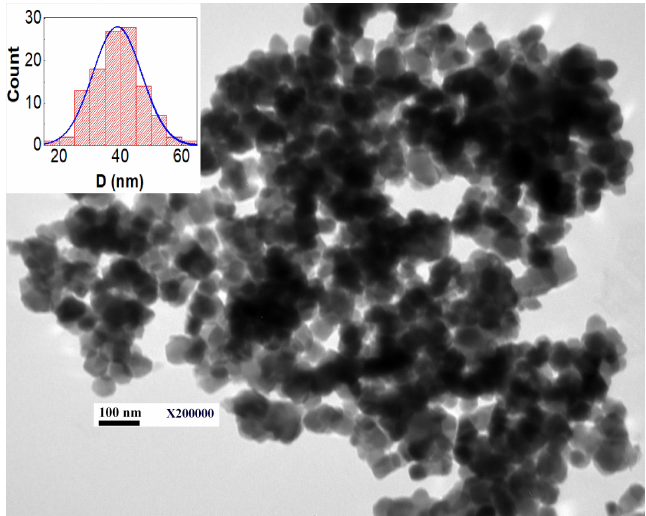
Figure 2. TEM image and particle size distribution histogram for the Cu 0.75 Co 0.25 Fe 2 O 4